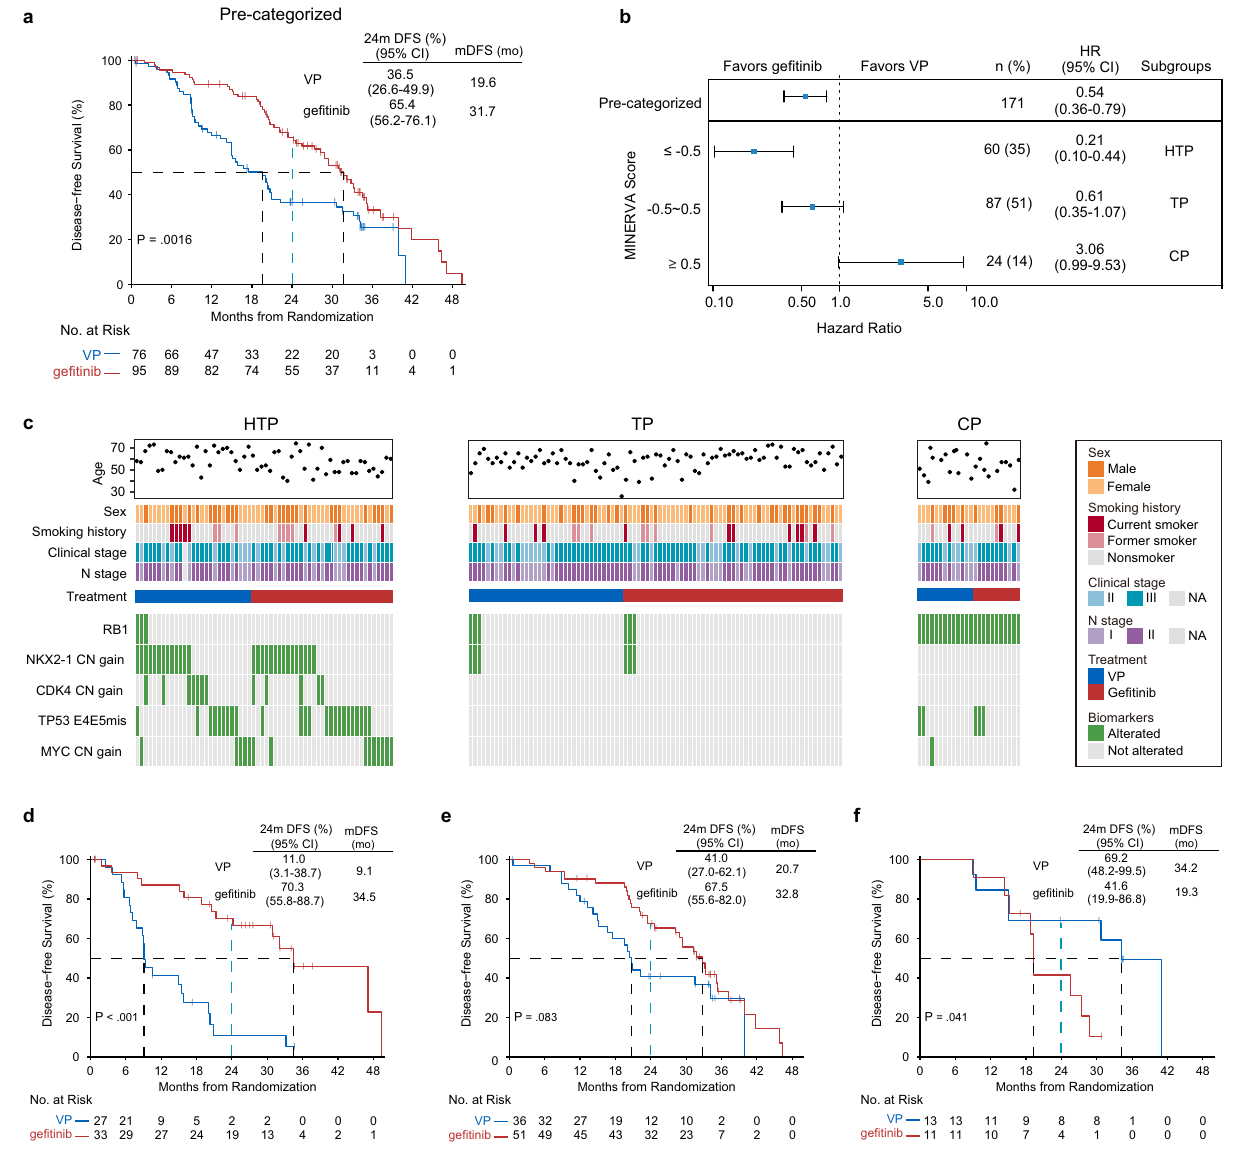
Fig. 2 Disease-free Survival (DFS) as per MINERVA subgroups. a Kaplan – Meier curves estimate DFS of the pre-categorized cohort which received adjuvant ge fi tinib or VP treatment ( N = 171). Two-sided P value was calculated using the log-rank test. b Forest plot showing the treatment-by-interaction hazard ratio (iHR) of DFS with the cox regression model in subgroups (HTP, highly TKI-preferable group; TP, TKI-preferable group; CP, chemo-preferable group) as classi fi ed by MINERVA score. Error bars indicate 95% con fi dence intervals of the iHRs. c Clinical characteristics and genetic alteration spectrums of fi ve predictive biomarkers in three MINERVA subgroups. d – f Kaplan – Meier curves of DFS for patients treated by adjuvant ge fi tinib or VP in three MINERVA subgroups. Black dotted lines indicate median DFS. Blue doted lines indicate 2-year survival rates (24 months). Two-sided P values were derived from the log-rank test. Exact statistical signi fi cance of DFS difference in the HTP group was 2.47 × 10 − 5